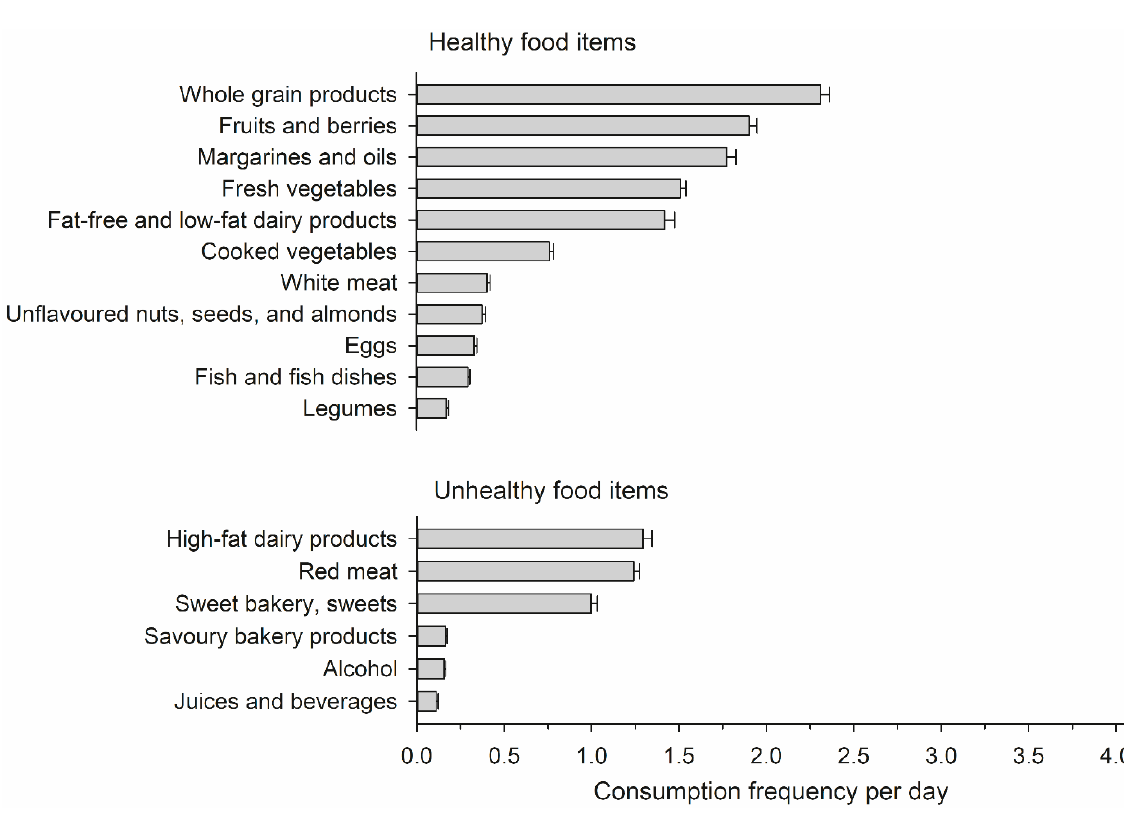
Figure 1. Mean daily consumption frequency for different groups of healthy and unhealthy food items. Whiskers show standard errors.